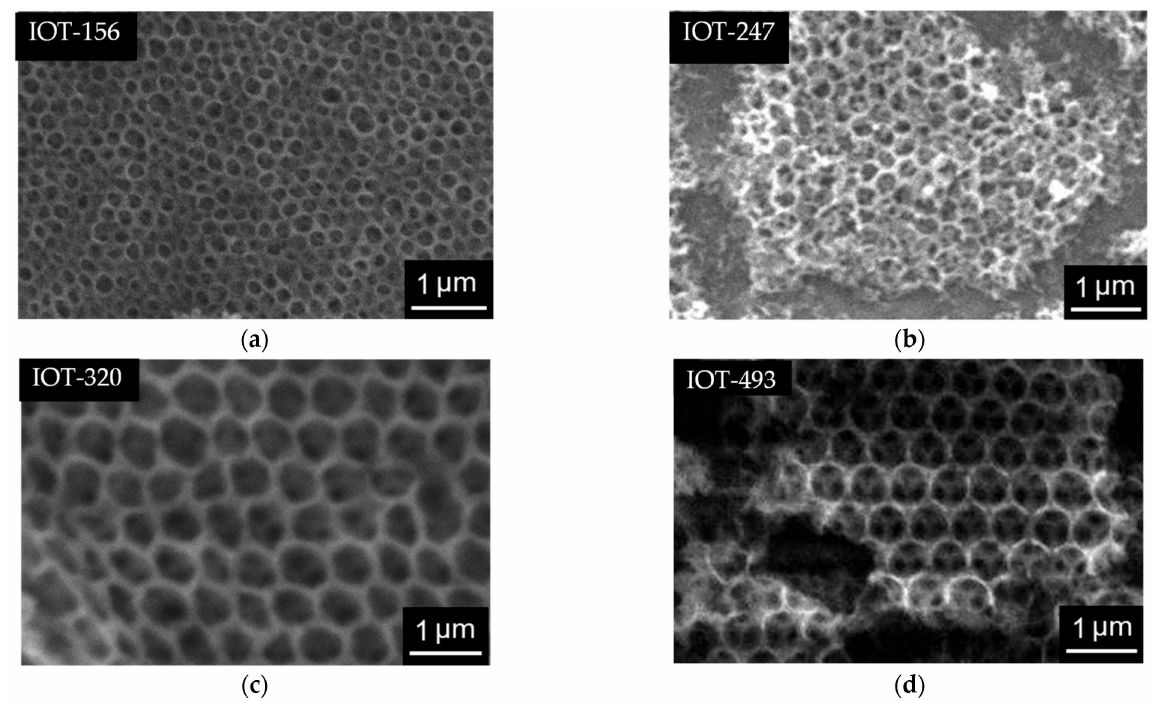
Figure 5. SEM images of: ( a ) IOT-156; ( b ) IOT-247; ( c ) IOT-320; ( d ) IOT-493.